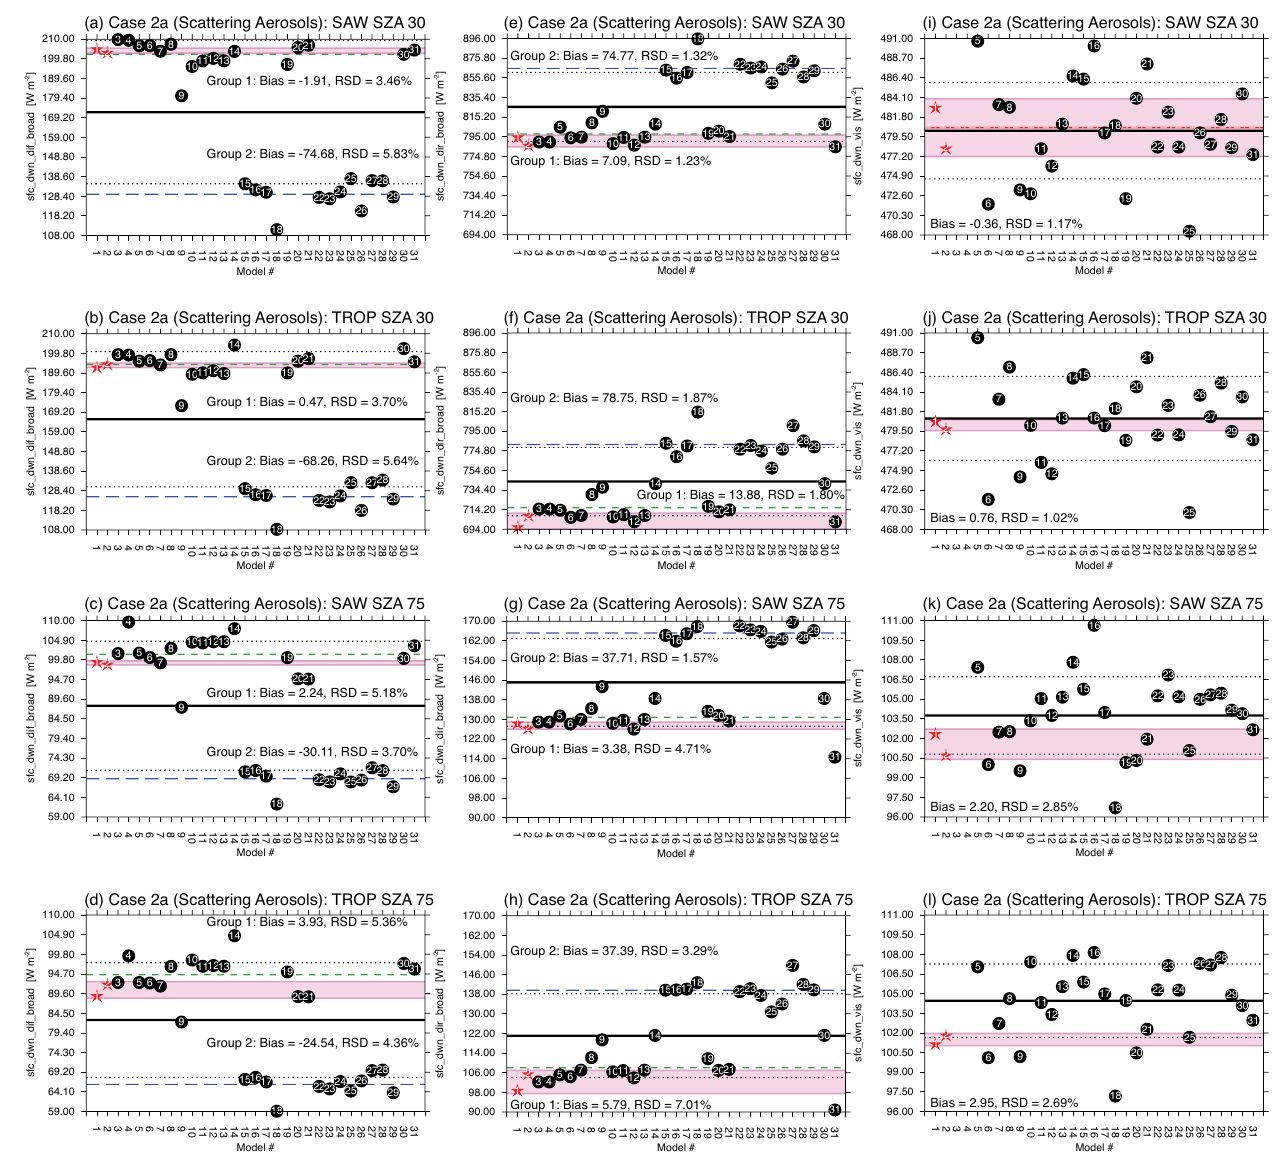
Fig. A5. Broadband diffuse (a–d) , broadband direct (e–h) , and UV-VIS (direct + diffuse) (i–l) flux down at the surface in Case 2a (Scattering Aerosols) as a function of atmosphere and solar zenith angle. LBL results are given as stars; non-LBL models are black circles. The pink shading indicates ± 1 standard deviation from the LBL mean. The non-LBL mean is given as the thick black line with ± 1 standard deviation indicated by dotted black lines. For UV-VIS fluxes, the absolute model bias relative to the LBL-mean is given as well as the RSD excluding the LBL models. Green and blue lines indicate the multi-model averages for the groups described in Table 4 for broadband fluxes; statistics are given for each group. Group 1 (green) includes Models # 3–14, 19–21, and 30–31; Group 2 (blue) includes Models #15–18 and 22–29.